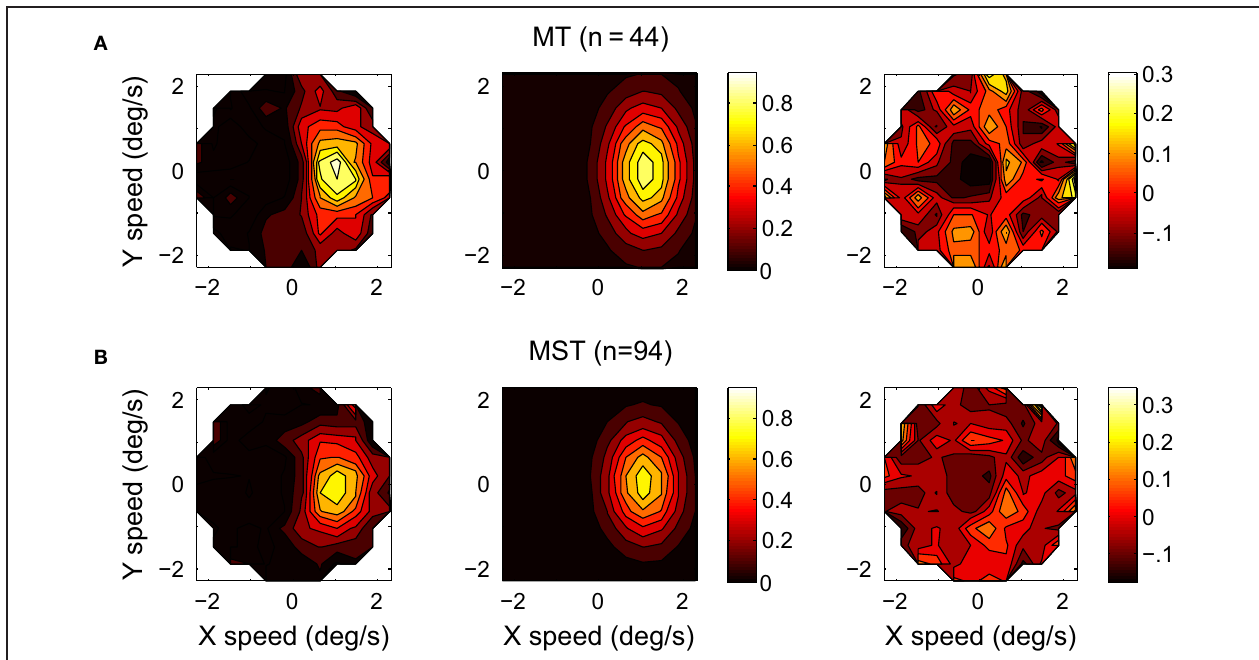
FIGURE 6 | The response profiles of the normalized and pooled populations of 44MT (A) and 94MST (B) units recorded in two monkeys. Columns from left to right: The response profile in velocity space; The six-parameter model fits; The residuals (MT: r 2 = 0 . 80; MST: r 2 = 0 . 82).